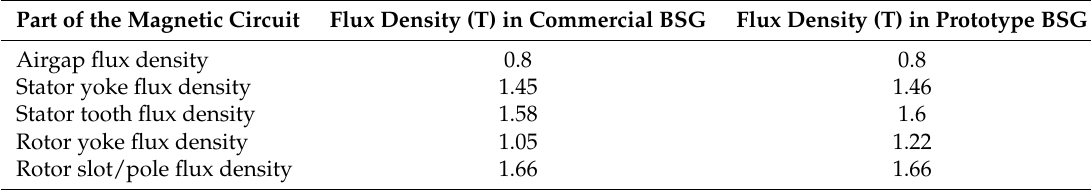
Table 2. Maximum values of flux density of the main generator part of BSG.